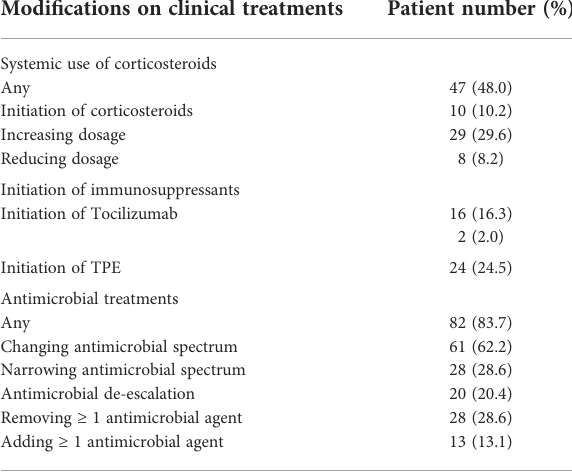
TABLE 4 Impact of mNGS results on clinical